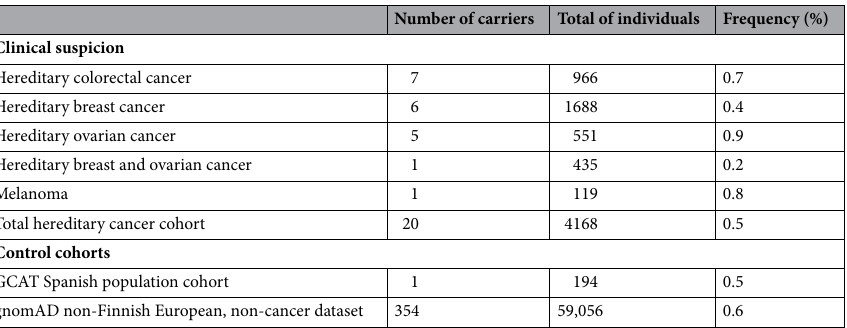
Table 1. BARD1 c.1977A>G carriers identified in a hereditary cancer cohort (classified by their clinical suspicion) and two control